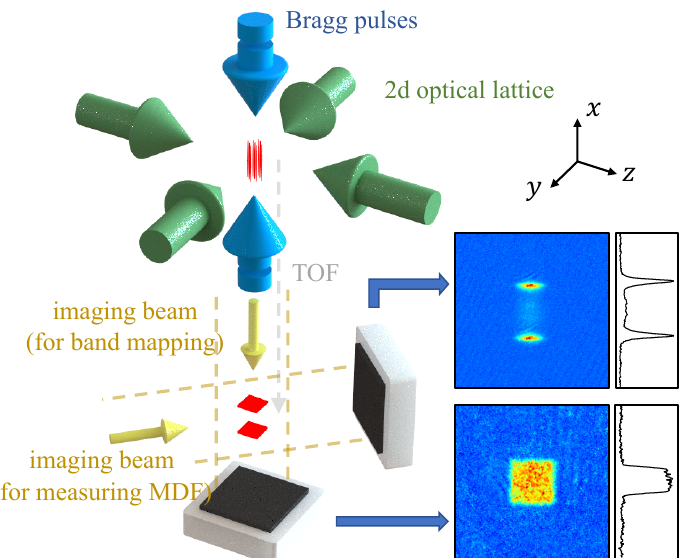
Figure 1: Experimental setup. The 1D Bose gas is prepared by adiabatically loading a BEC into a 2D optical lattice (green arrows). A sequence of Bragg pulses (blue arrows) is applied to excite the atoms to oscillate and collide in the 1D traps. After some duration, the atoms are released from the 1D traps and detected after TOF (yellow arrows), providing us the longitudinal MDF (horizontal imaging) and the fractional population of atoms in transverse states (vertical